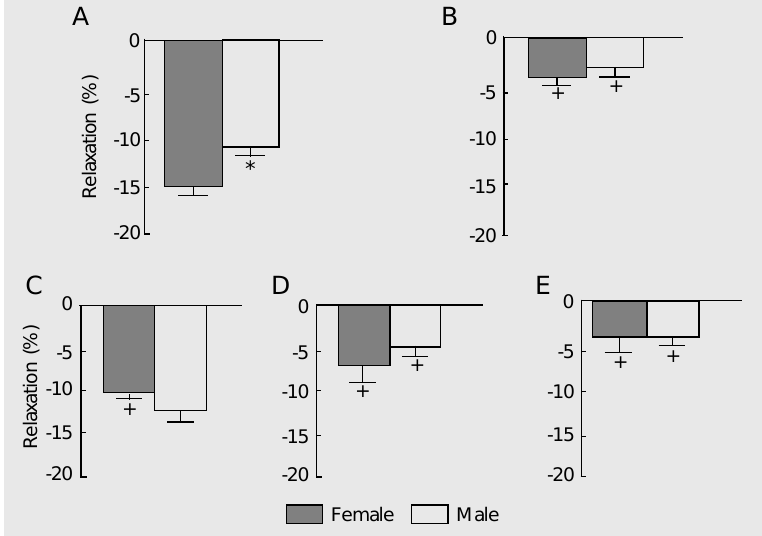
Figure 1. Relaxing response to 17ß-estradiol in the coronary vascular bed of female and male animals before (A, control, N = 10) and after endothelium removal (B, N = 10) or perfusion with L-NAME (C, N = 11), indomethacin (D, N = 11) or clotrimazole (E, N = 9). Data are reported as means ± SEM. *P < 0.01 compared to females before the different treatments (unpaired Student t -test). + P < 0.01 compared to the same group under control conditions (A) (paired Student t